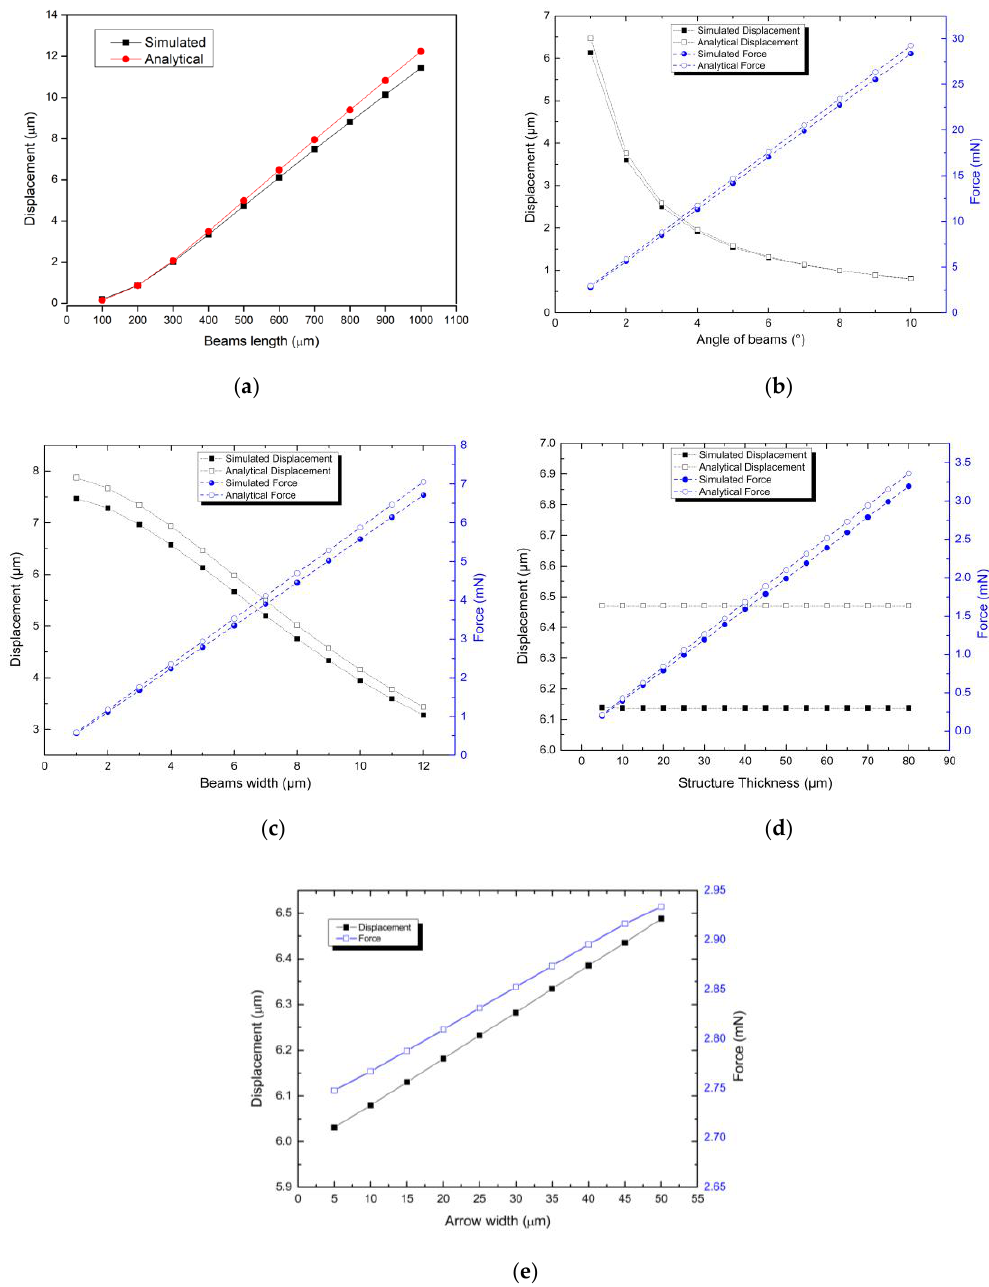
Figure 7. Chevron actuator. ( a ) Beam length vs. displacement. ( b ) Pre-bend angles of beams vs. displacement and force. ( c ) Beam width vs. displacement and force. ( d ) Structure thickness vs. displacement and force. ( e ) Arrow width vs. displacement and force.